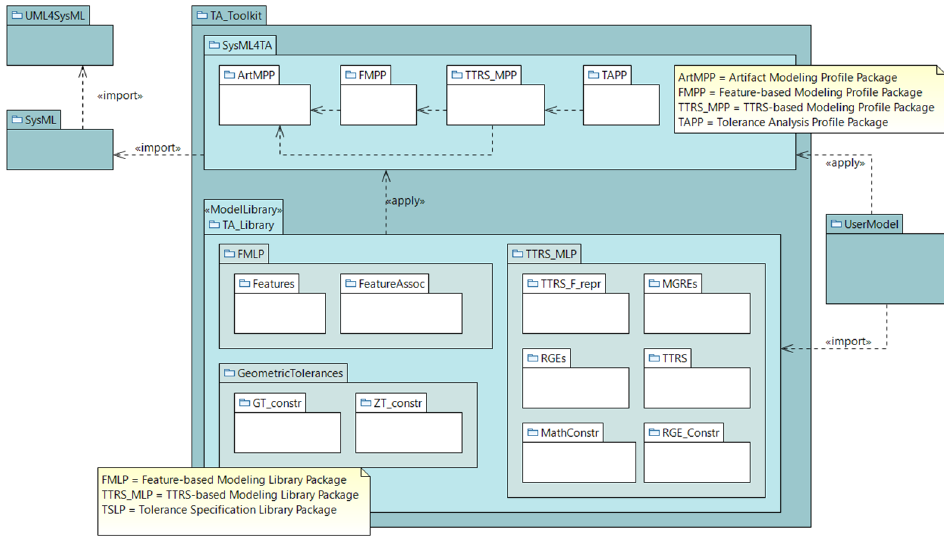
Figure 3. Package diagram of the developed models.